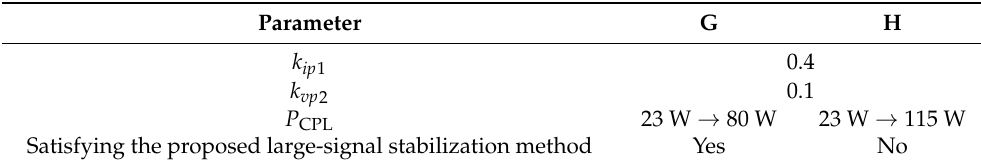
Table 6. Experimental parameters of Groups E and F. Table 7. Experimental parameters of G and